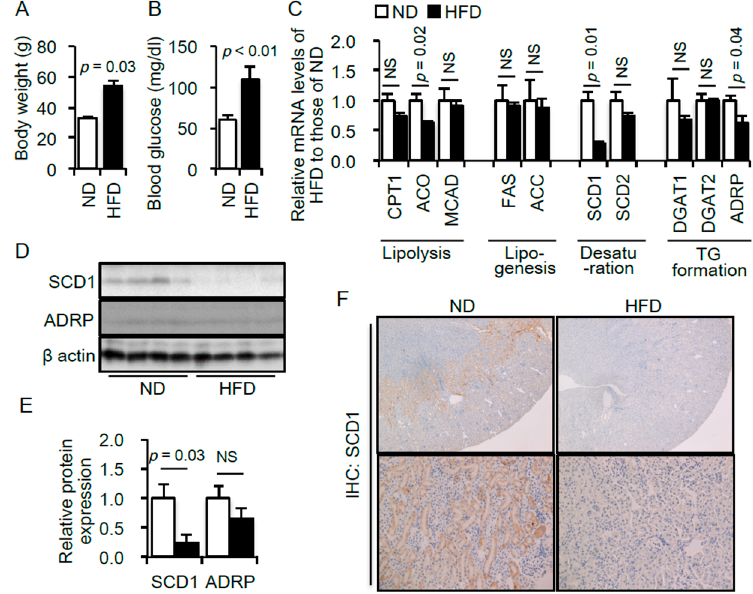
Figure 1. Body weight ( A ) and blood glucose levels ( B ) of mice fed with either normal diet (ND, n = 5) or high-fat diet (HFD, n = 5); ( C ) Expression levels of mRNAs related to lipid metabolism in the kidneys of mice fed an ND or a HFD. Data are expressed as a relative ratio to the ND group; ( D ) Representative immunoblot of SCD1 and ADRP. β -actin was used as a loading control; ( E ) Quantitative results of the immunoblots. Data are expressed as a relative ratio to the ND group. p < 0.05 indicates statistical significance; ( F ) Immunohistological analysis of SCD1 in kidney sections of mice fed an ND or a HFD. Magnification: ×40 ( upper ), ×200 ( lower ). Data are shown as mean ± SD. p < 0.05